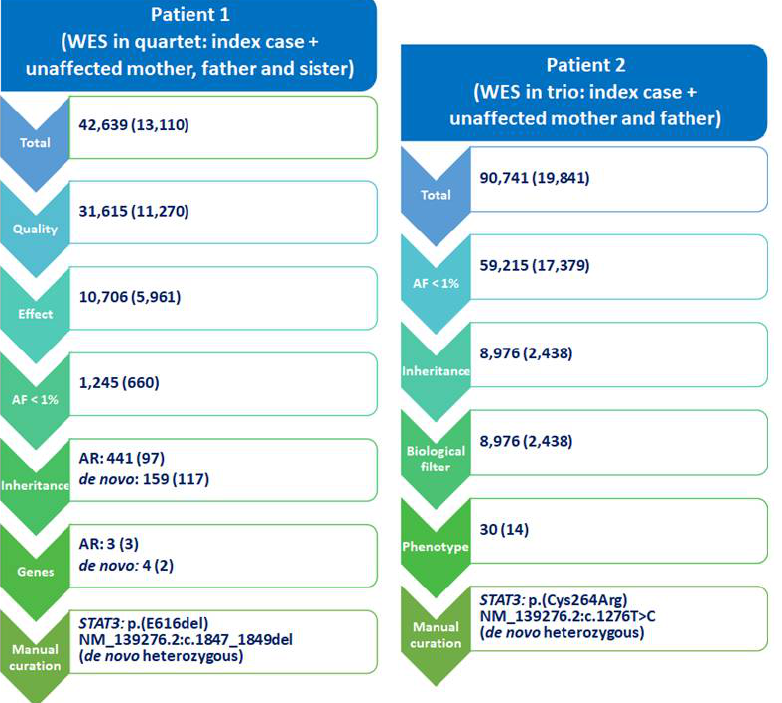
Figure 2. Different filtering strategies applied to WES data analysis. Number of variants obtained in each filtering step is indicated, with the number of genes in parentheses. The sequential filtering strategy which led to the prioritization of probably pathogenic candidate variants, to explain the patients’ phenotype of severe short stature associated with immune dysregulation, was different for each case. For patient 1, variants considered fulfilled the following criteria: adequate quality, an effect on the protein (either located in coding region: nonsense, missense, in-frame deletions or insertions, and frameshift variants), allelic frequency (AF) < 1% in the general population (according to ExAC), consistent with the presumed inheritance pattern (either autosomal recessive (AR) with two variants in different alleles of the same gene or de novo variant were suspected, since her parents and sister were unaffected), and variants included in a 250-candidate gene list. For patient 2, filtering criteria for variants present in the trio included: AF < 1%, AR or de novo inheritance pattern, a biological filter (genes related to lymphocyte activation), and phenotype (eczema, colitis, autoimmune thyroiditis, autoinflammatory disorders). For both cases, a final step of manual curation of several variants was required to select the prioritized STAT3